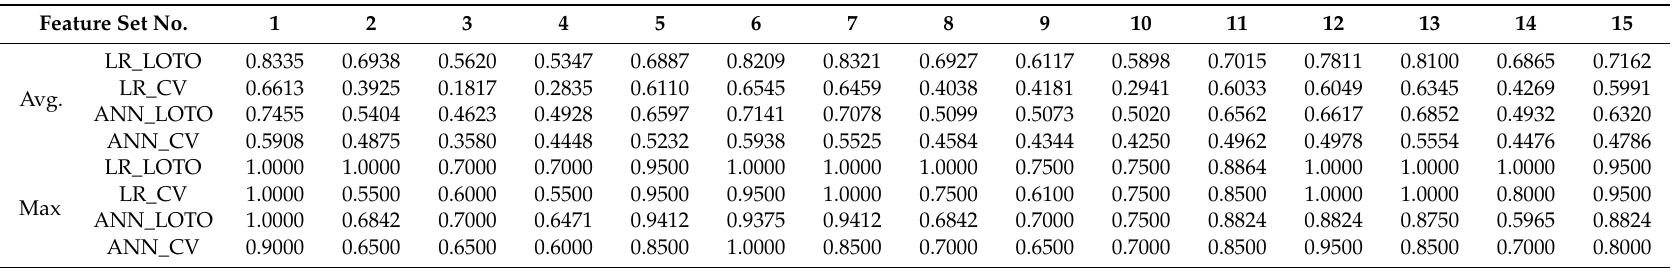
Table A3. Average and maximum decoding accuracies for each feature set using two classifiers with two validation methods (1 s window for EEG features). Feature Set No.